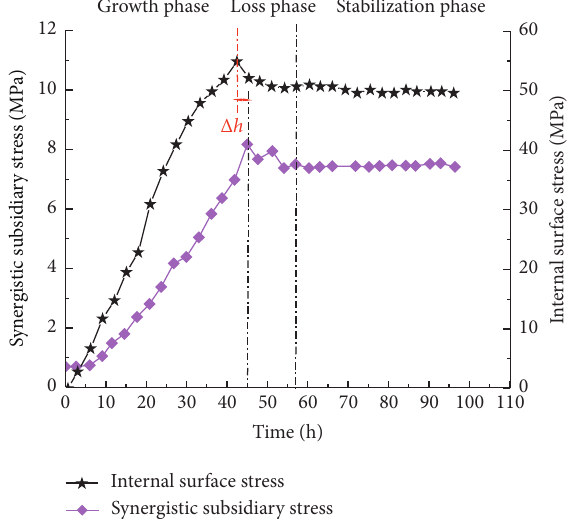
Figure 11: Evolution curve of internal interface stress and boundary additional coordinated stress.